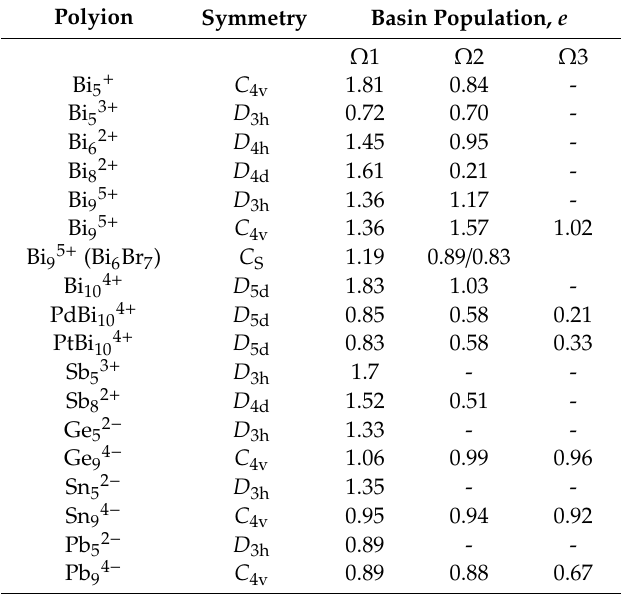
Table 2. Symmetries of optimized structures and bond basin populations for main-group clusters. Polyion Symmetry Basin Population,